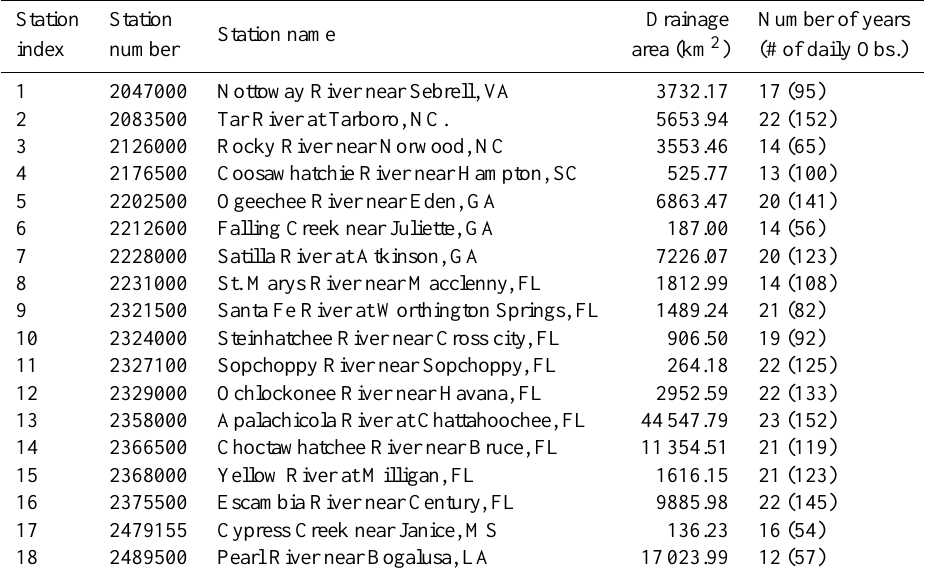
Table 1. Baseline information for 18 selected stations showing the number of years of observed daily records of TN available in the Water- Quality Monitoring Network (WQN) database. Values in the parentheses under number of years column show the total number of daily observations available for each station.